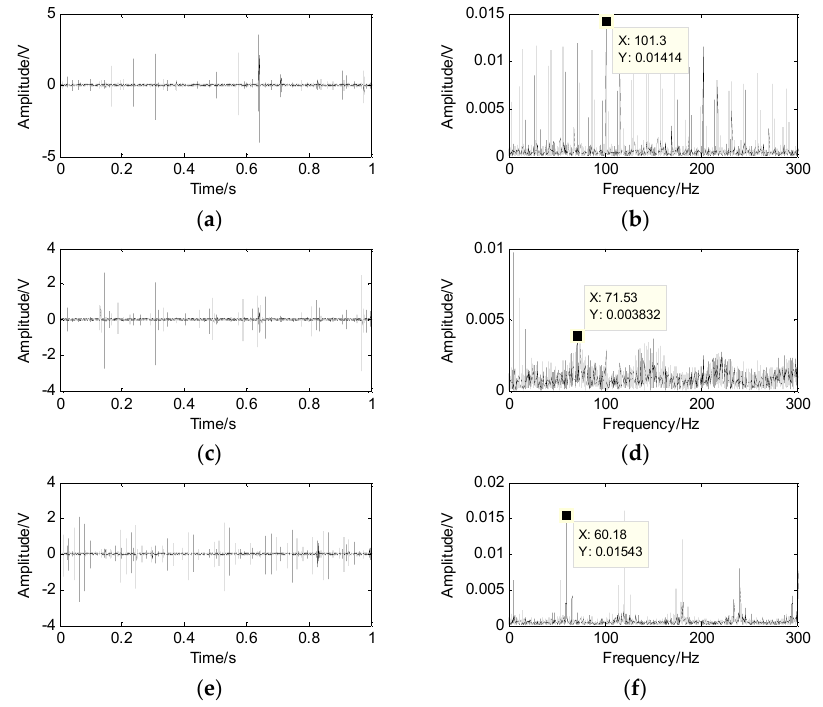
Figure 12. The separation of source signal and its spectrum by the proposed method. ( a ) waveform of inner-race defect; ( b ) spectrum of inner-race defect; ( c ) waveform of roller defect; ( d ) spectrum of roller defect; ( e ) waveform of outer-race defect; ( f ) spectrum of outer-race defect.